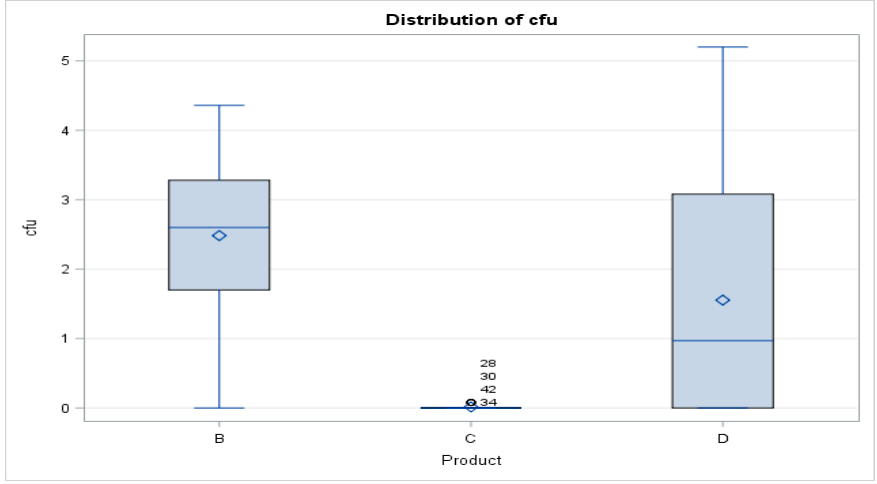
Figure 1. Bacillus strains in log CFU/g after exposure in Products A, B, and C without neutralizers.